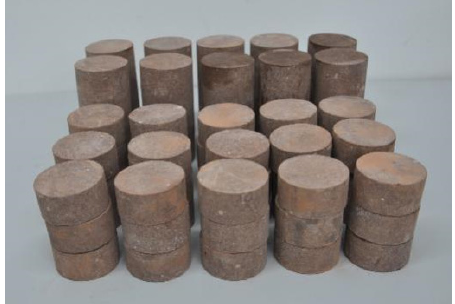
Figure 1. Some of the prepared rock specimens.